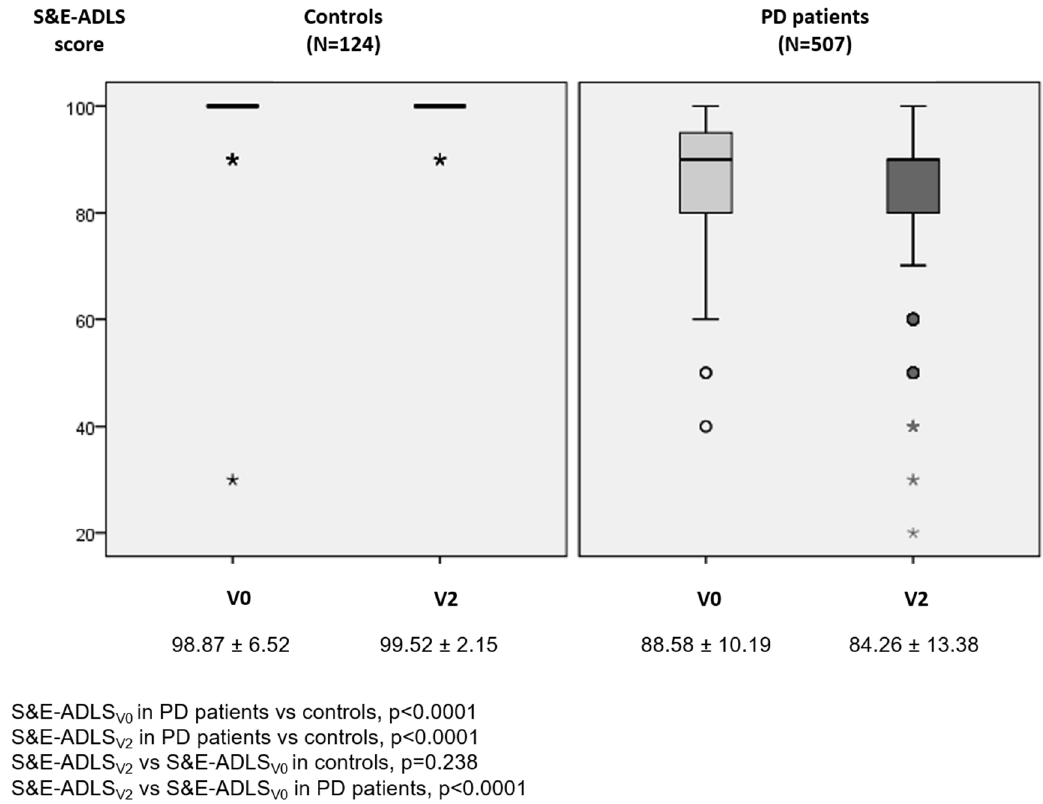
Figure 1. Change in S&E-ADLS score from V0 to V2 in controls (left) and PD patients (right). S&E-ADLS score at V0 in PD vs. controls, * p < 0.0001 (Mann–Whitney–Wilcoxon test); S&E-ADLS score at V2 in PD vs. controls, p < 0.0001 (Mann–Whitney–Wilcoxon test); S&E-ADLS score at V2 vs. S&E-ADLS score at V0 in controls, p = 0.238 (GLM repeated measure adjusted to age and gender); S&E-ADLS score at V2 vs. S&E-ADLS score at V0 in PD patients, p < 0.0001 (GLM repeated measure adjusted to age, gender, LEDD at V0 and LEDD at V2). PD, Parkinson´s disease; S&E-ADLS, Schwab & England Activities of Daily Living Scale.